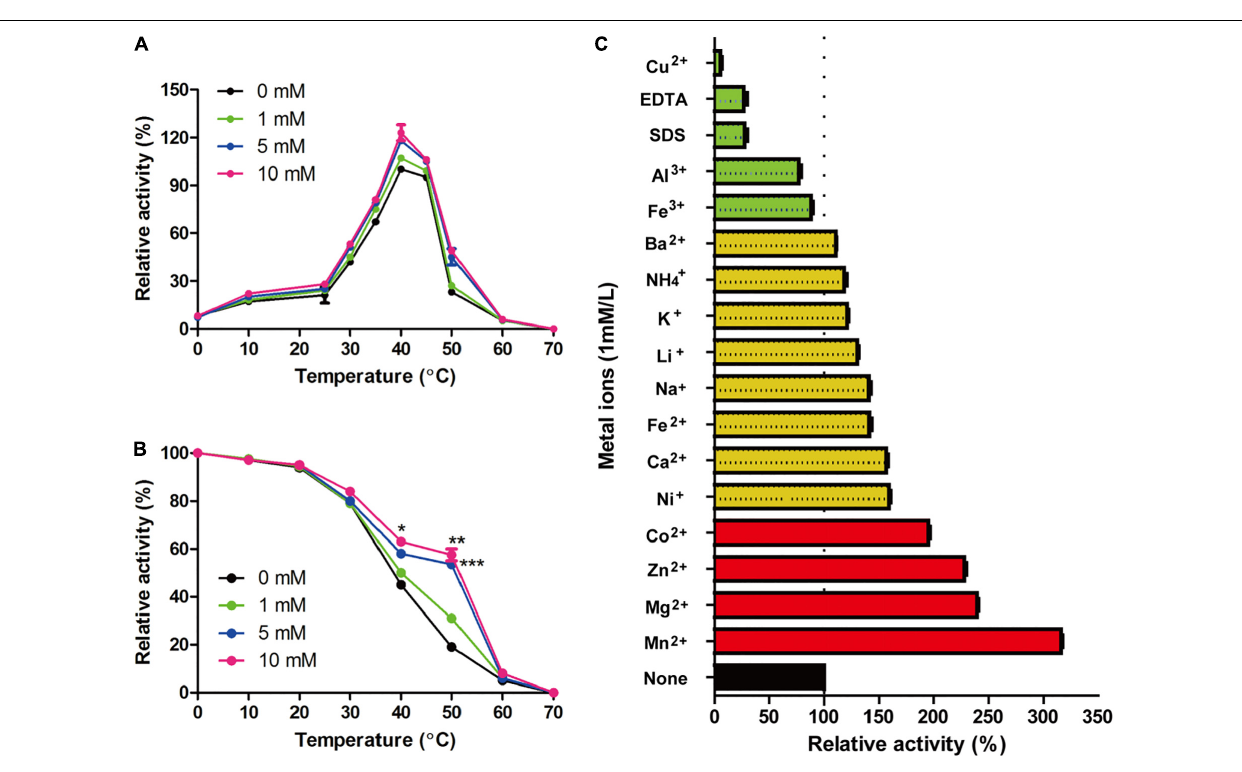
FIGURE 4 | Effect of zinc ions and other metal ions on enzymatic activity of Gal42. (A) Effect of zinc ions and temperature on the activity of Gal42. (B) Effect of zinc ions on thermo-stability of Gal42. (C) Effects of metal ions, EDTA, and SDS on the activity of Gal42. Activity without addition of chemicals was defined as 100%. The values are the mean values ± standard deviations of three experiments in three replicates. * p < 0.05; ** p < 0.01; and *** p <